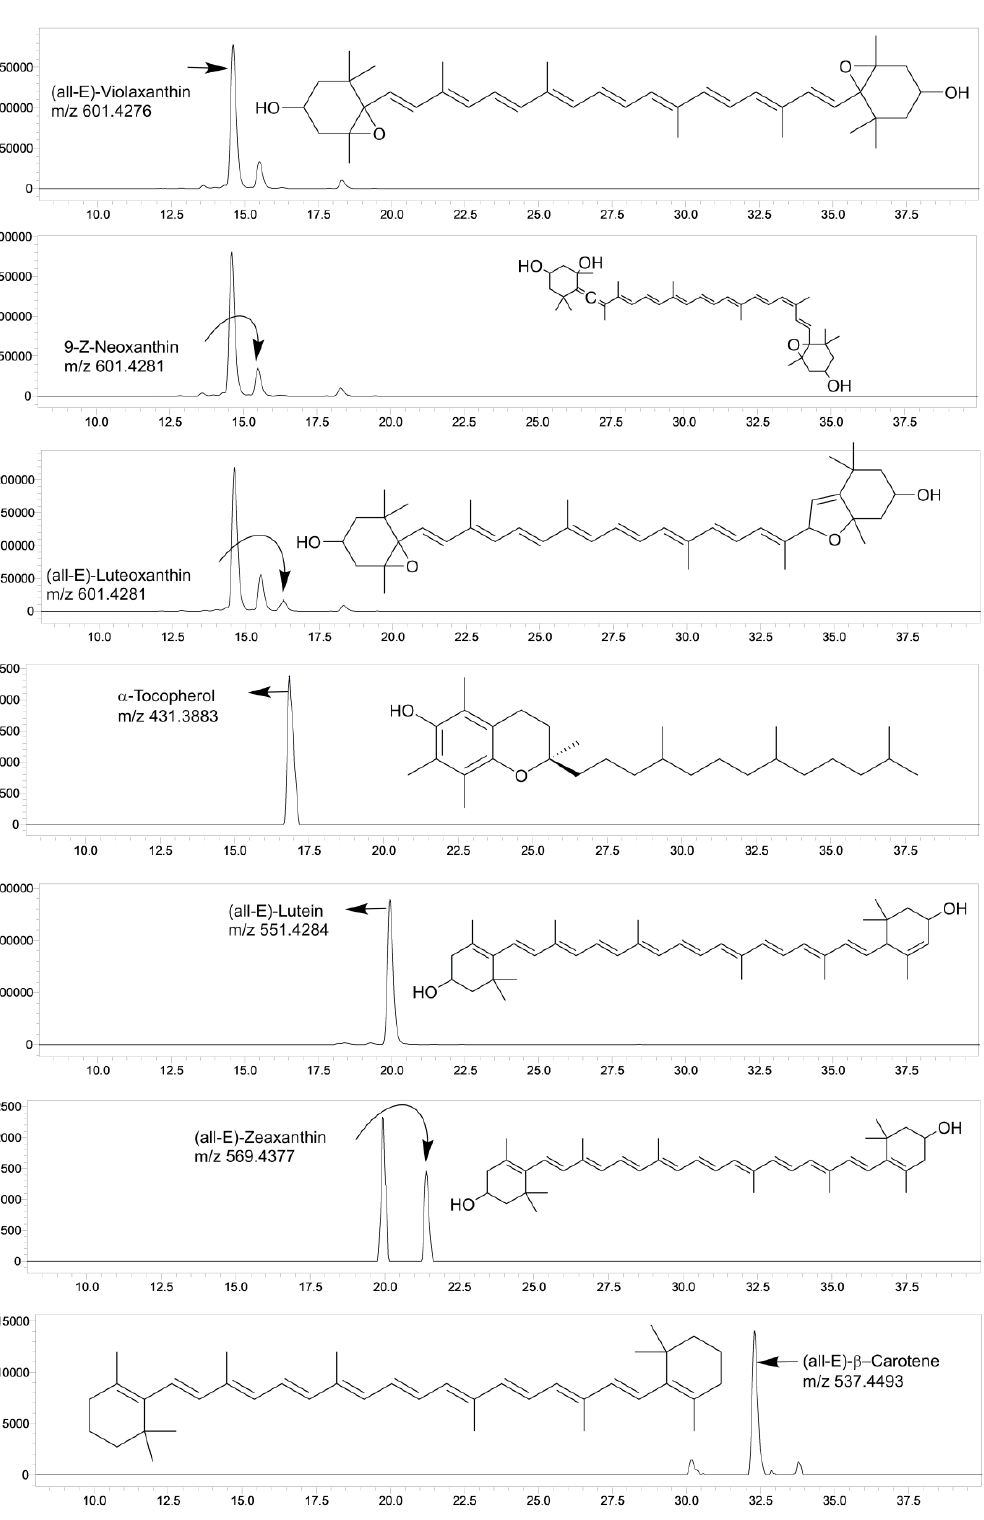
Figure 1. Representative LC-SIM/MS chromatograms of the carotenoids and α-tocopherol detected in the studied traditional green leafy vegetables (GLVs).